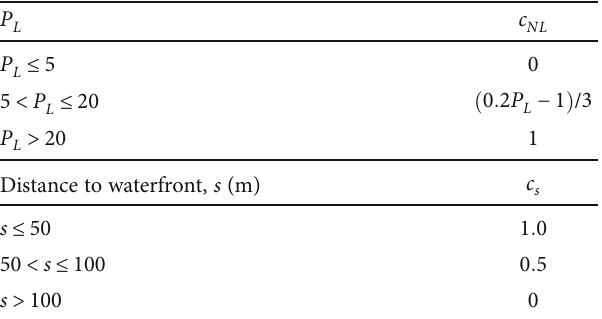
Table 1: Modi fi cation factors for fl ow pressure